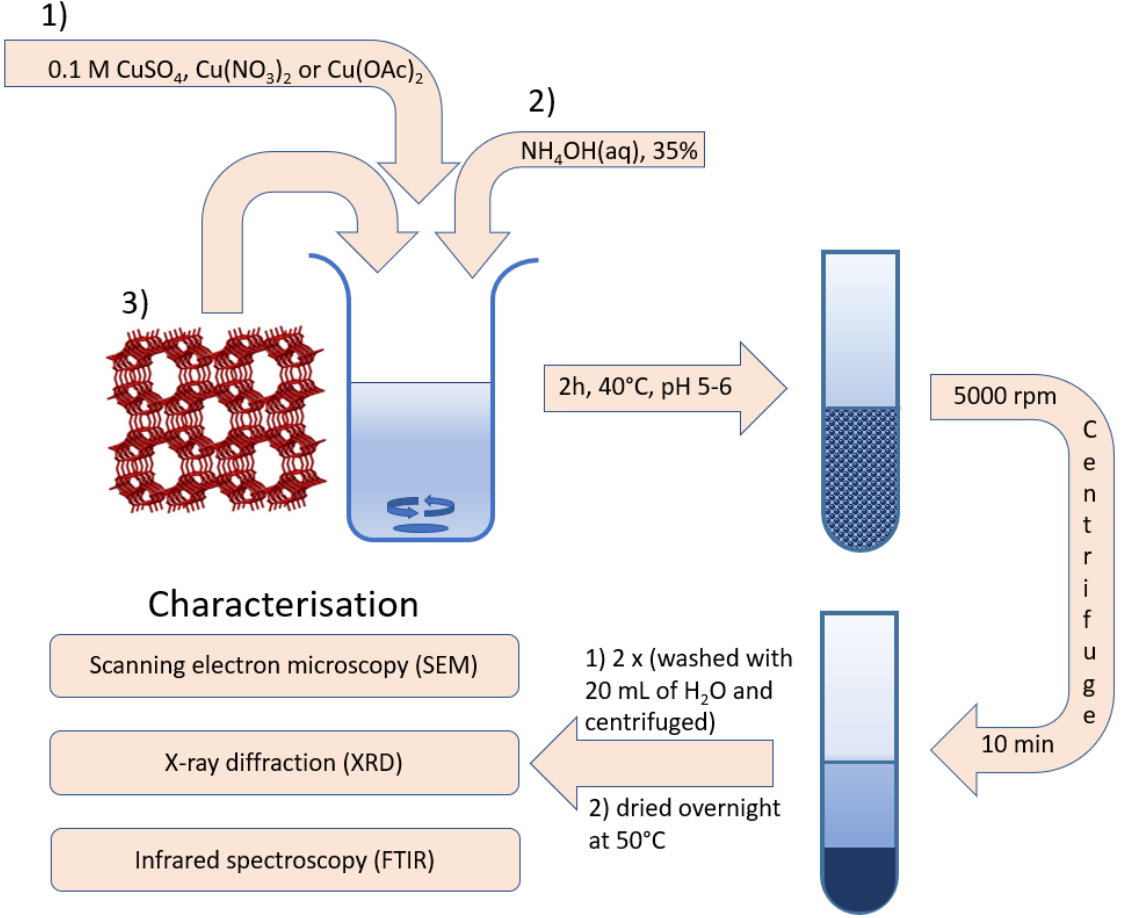
Figure 1. Cu ‐ zeolite preparation